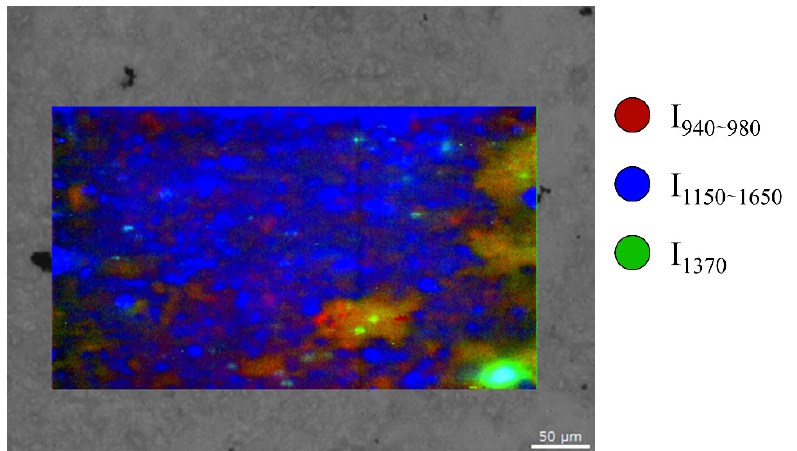
Figure 9. Raman imaging of the octacalcium phosphate substrate exposed to both RANKL and bisphosphonates. The red color identifies the phosphate groups, blue identifies the amides (I, II and III) and green identifies the band at 1370 cm − 1 associated with differentiated osteoclasts.